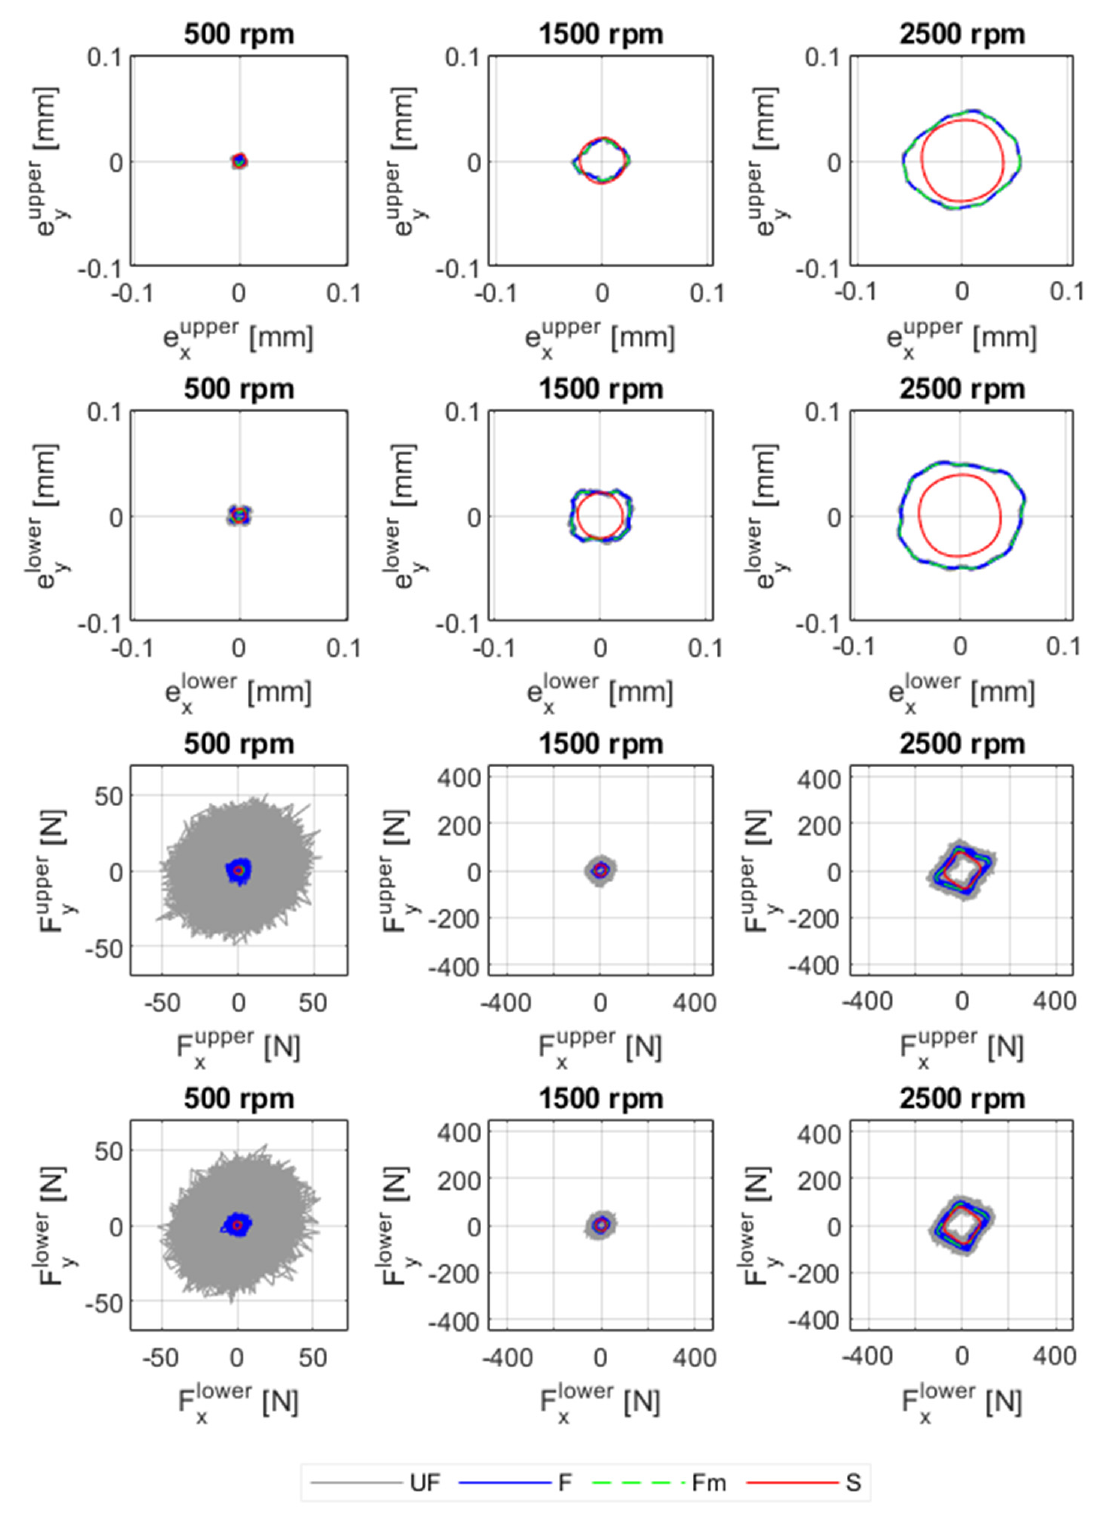
Figure A1. Orbits and bearing forces of the upper and lower bearings with 1.7 × 10 − 3 kg · m unbalance magnitude and at 500 rpm, 1500 rpm, and 2500 rpm. UF: unfiltered measurement signal; F: filtered measurement signal by a band pass filter; S: simulation.